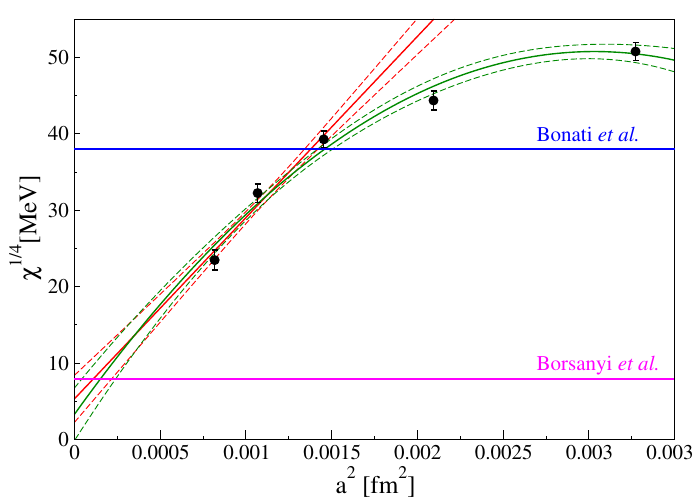
Figure 11 . Fourth root of the topological susceptibility, as a function of a 2 , for T ’ 430 MeV. To two bands represent the result of two di(cid:11)erent continuum extrapolations, taking into account respectively O ( a 2 ) or O ( a 4 ) corrections. The two horizontal lines are the continuum extrapolations reported respectively in refs. [39] and [37] at the same